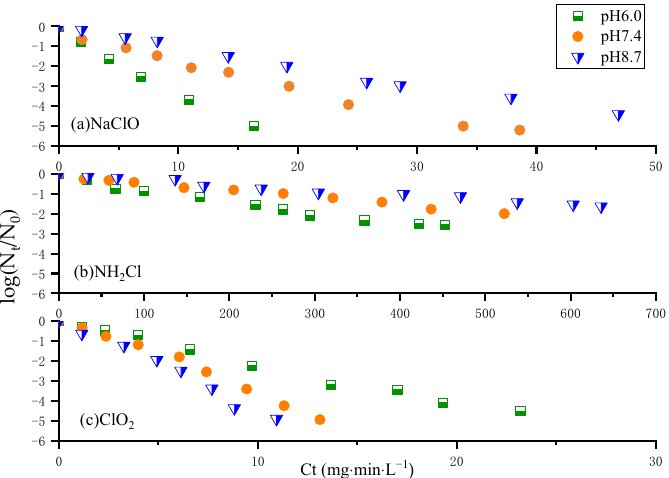
Figure 5. Inactivation effect on N. europaea using ( a ) free chlorine, ( b ) monochloramine and ( c ) chlorine dioxide at varying pH. Experiments were conducted within the target disinfectant concentration of 1 mg · L − 1 Cl 2 . The disinfectant susceptibility of N. europaea was analyzed at pH 6.0, pH 7.0 and pH